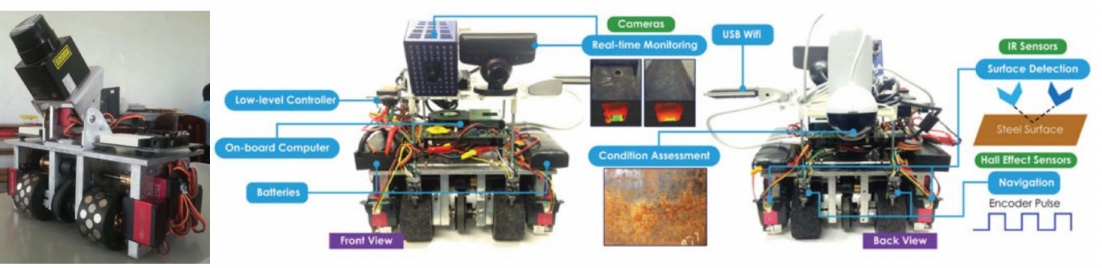
Figure 36. Automated robot prototype carrying the sensors for the inspection [110].